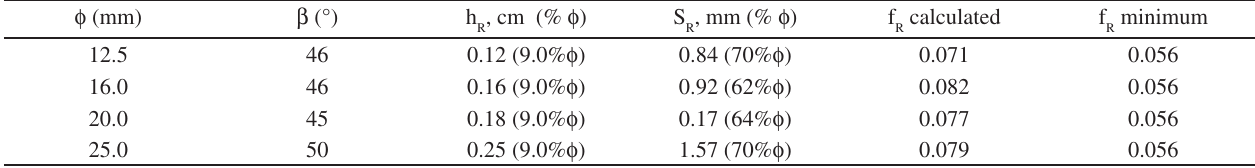
Table 4. Characterization of steel bars (rib’s bar).